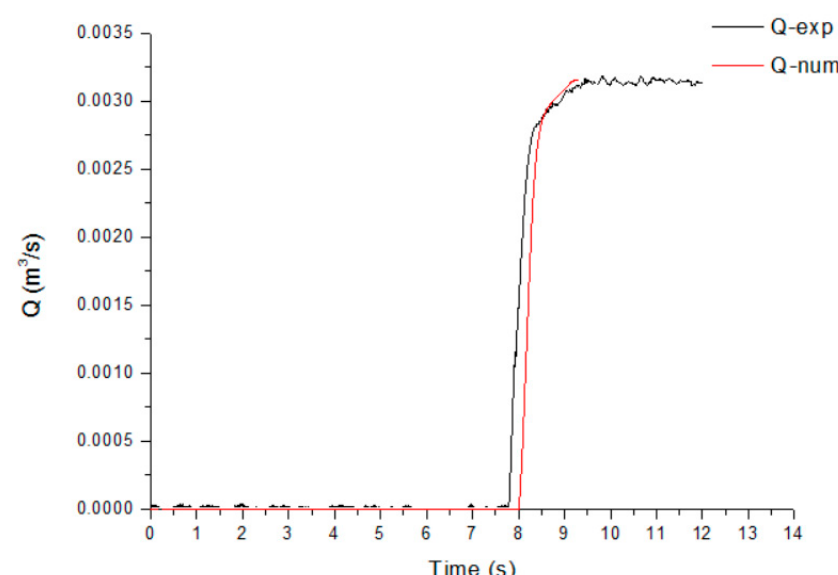
Figure 16. Comparison of the experiment and simulation flows.